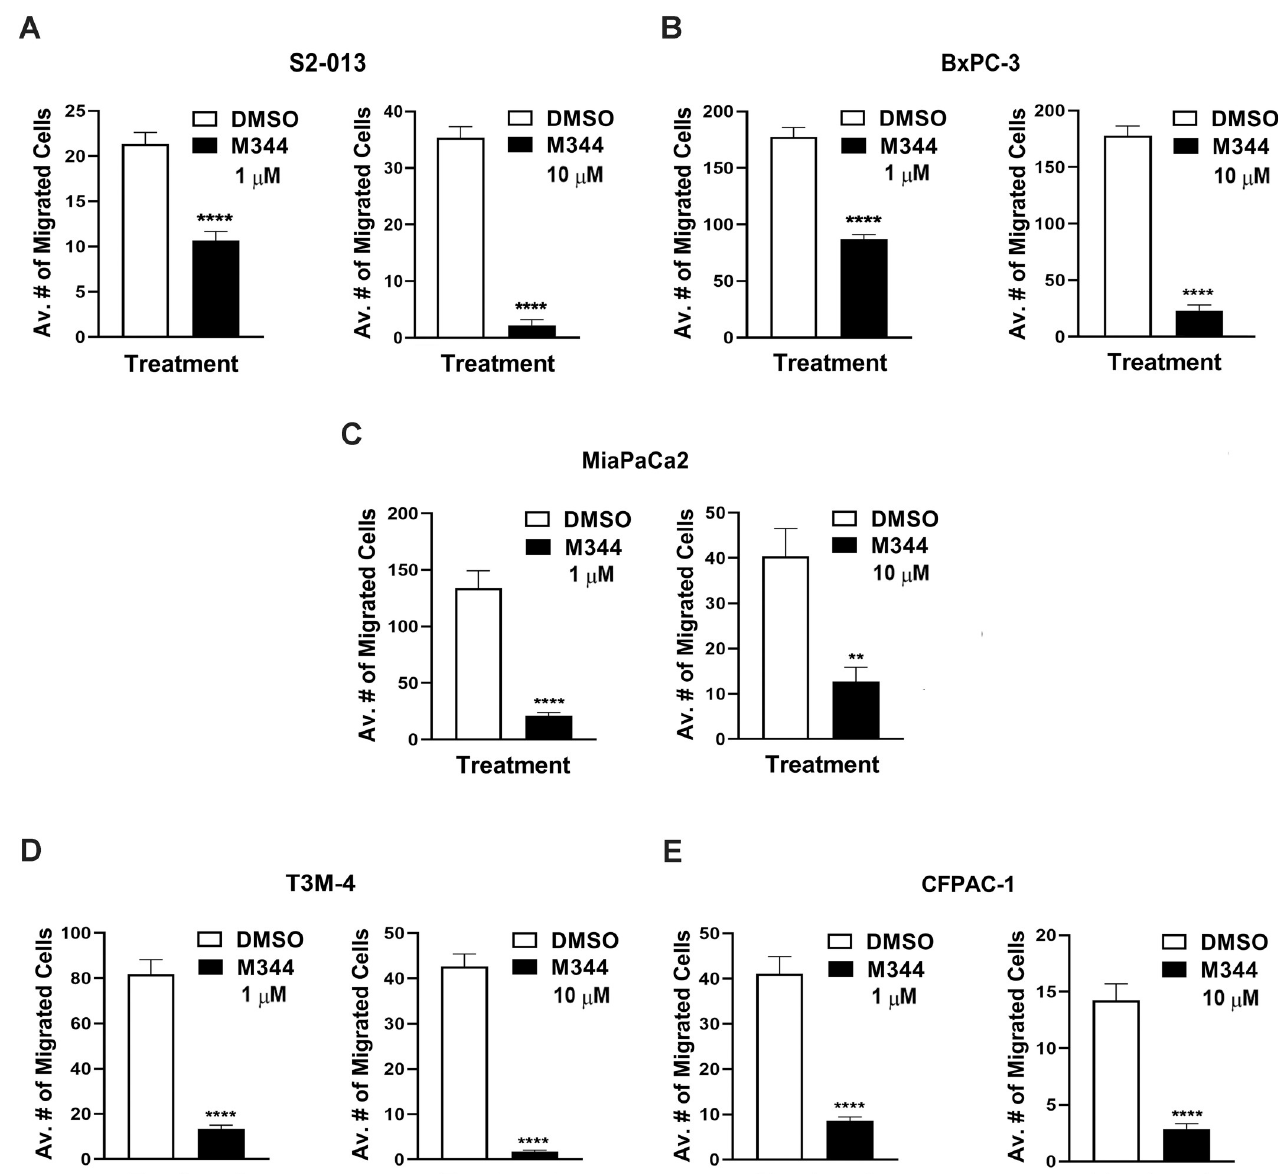
Fig 5. Migration of pancreatic cancer cells is reduced upon treatment with M344. Transwell assays were performed to assess the migration of ( A ) S2-013, ( B ) BxPC-3, ( C ) MIA PaCa-2, ( D ) T3M-4, and ( E ) CFPAC-1 cells following treatment with 1 μ M or 10 μ M of M344 (or with 0.1% DMSO, as the vehicle control) for 24 h. For the transwell assays, after treatment the cells were plated into 3 separate 8- μ m inserts (1x10 5 cells/insert) in the presence of 1 μ M M344, 10 μ M M344, or 0.1% DMSO and incubated for 24 h. Cells were fixed and stained, and photographs of 3 random fields were taken for each of the inserts. The results of counts of the stained, migrated cells were averaged. The graph shows the average numbers of cells that migrated, and each error bar represents the standard error of the mean. The presented graph for the S2-013 cells is representative of the results from 3 separate experiments; the full experimental set of counts for each of the other cell lines was done once. The results of 0.1% DMSO control treatment versus the 1 μ M or the 10 μ M M344 treatment were compared using Student’s t test. The asterisks indicate the following p values: � p < 0.05, �� p < 0.01, ��� p < 0.001, and ���� p <